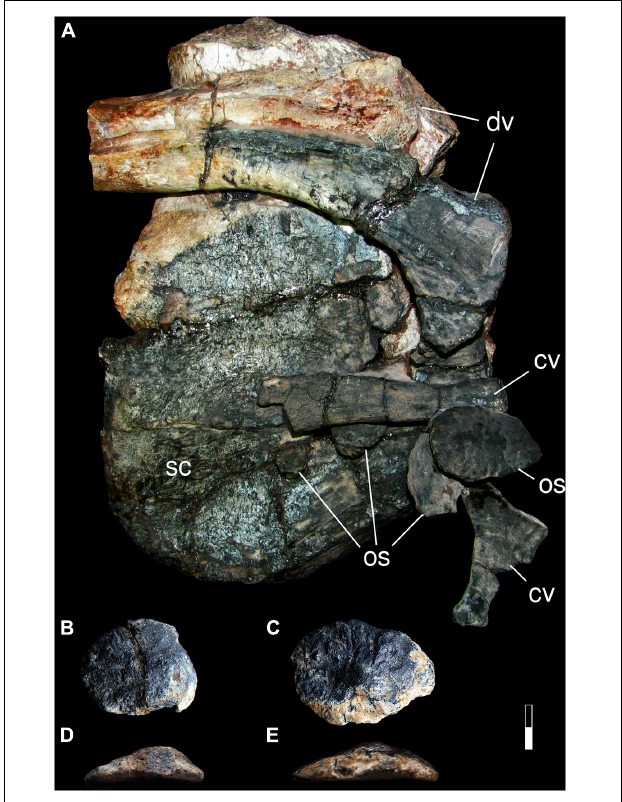
FIGURE 13 | Osteoderms of Provelosaurus americanus . (A) UFRGS-PV-0359-P, partial scapulocoracoid in medial view, with attached ribs and osteoderms. (B–D) UFRGS-PV-0233-P, lateral osteoderms from top of the vertebrae in (B,C) dorsal and (D,E) ?lateral views. Scale bar represents 15 mm for (A) and 10 mm for (B–E) . cv, cervical rib; dv, dorsal rib; os, osteoderm; sc,